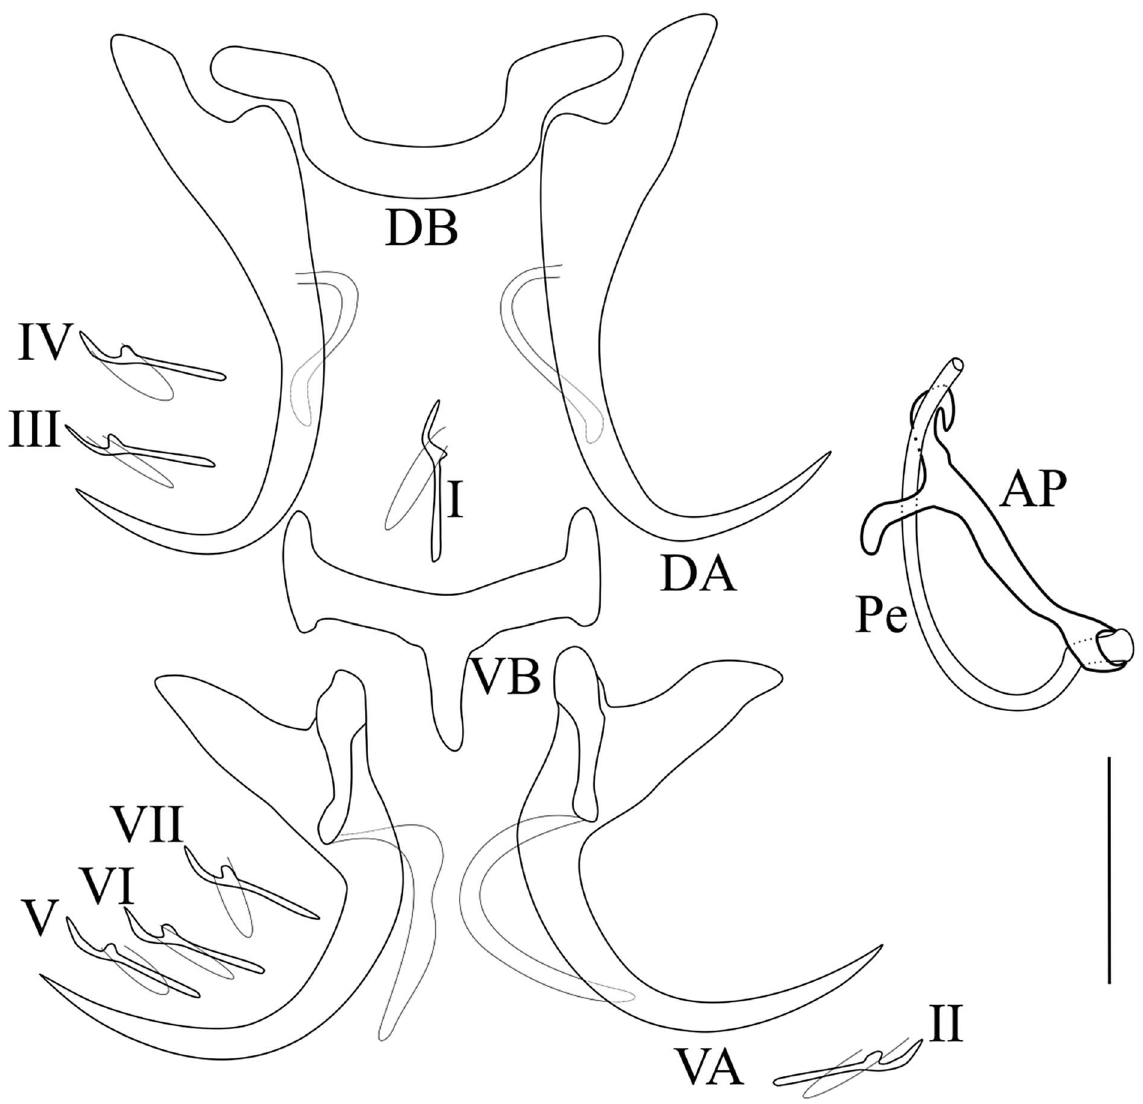
Figure 2. Sclerotized parts of Synodontella angustupenis n. sp. Scale bar = 20 l m. AP, accessory piece; DA, dorsal anchor; DB, dorsal bar; VA, ventral anchor; VB, ventral bar; Pe, penis; I-VII,